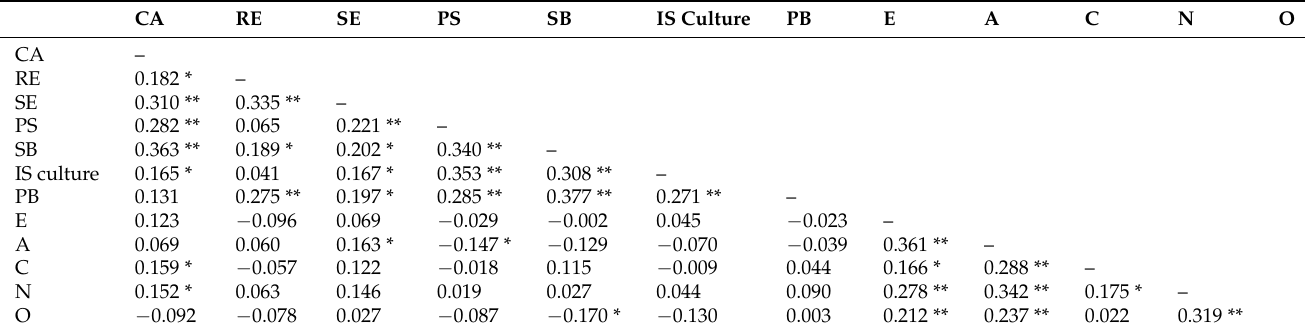
Table 8. Correlations between perception and personality.